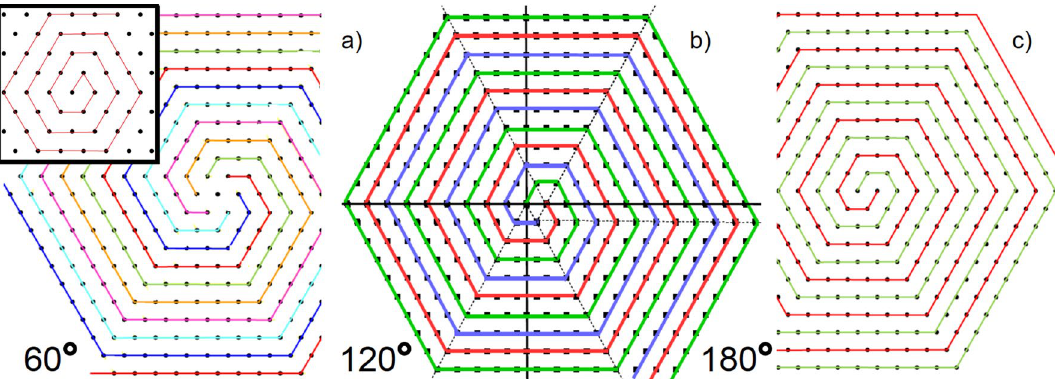
Figure 3. Plot of the different sets of spirals equivalent from the symmetry point of view (except the one in the inset) to the vortex state, which is ( b ). Only the central one occurs. All dipoles point clockwise. See text for